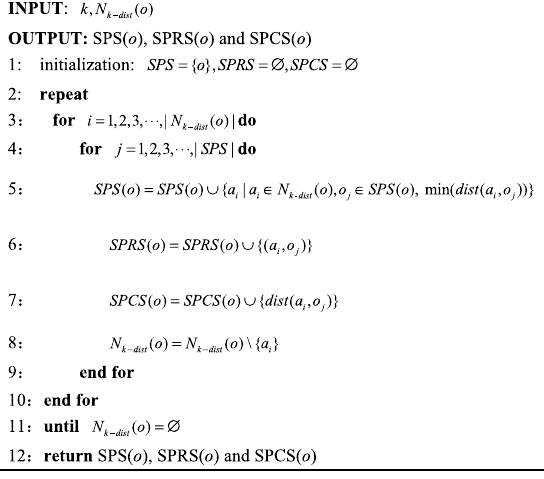
Algorithm 1. Calculate SPS, SPRS and SPCS of object o .